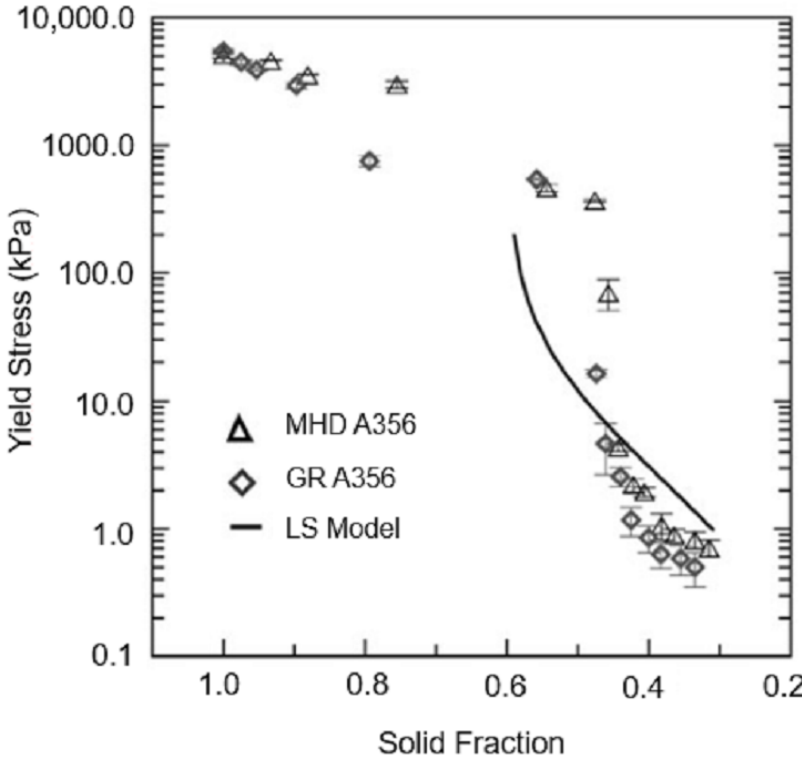
Figure 10. A comparison between measured average yield stresses of grain refined (GR) A356 and magneto-hydrodynamically stirred (MHD) A356 alloys with yield stress values predicted by the Loue–Sigworth (LS) model